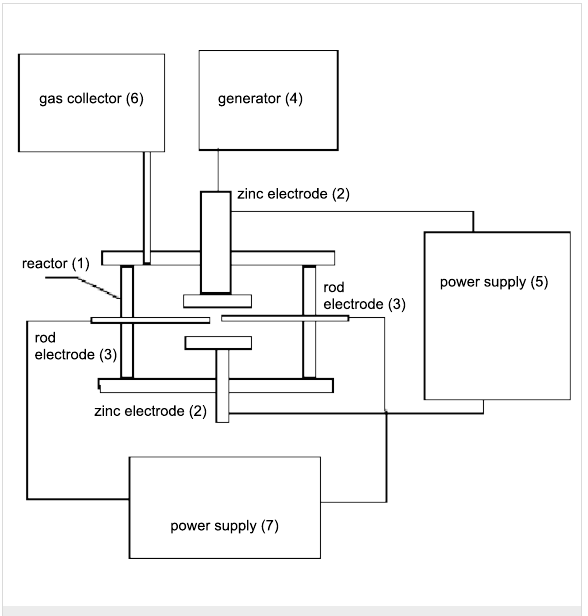
Figure 1: Block diagram of the experimental setup for the production of ZnO NPs in a sonoplasma